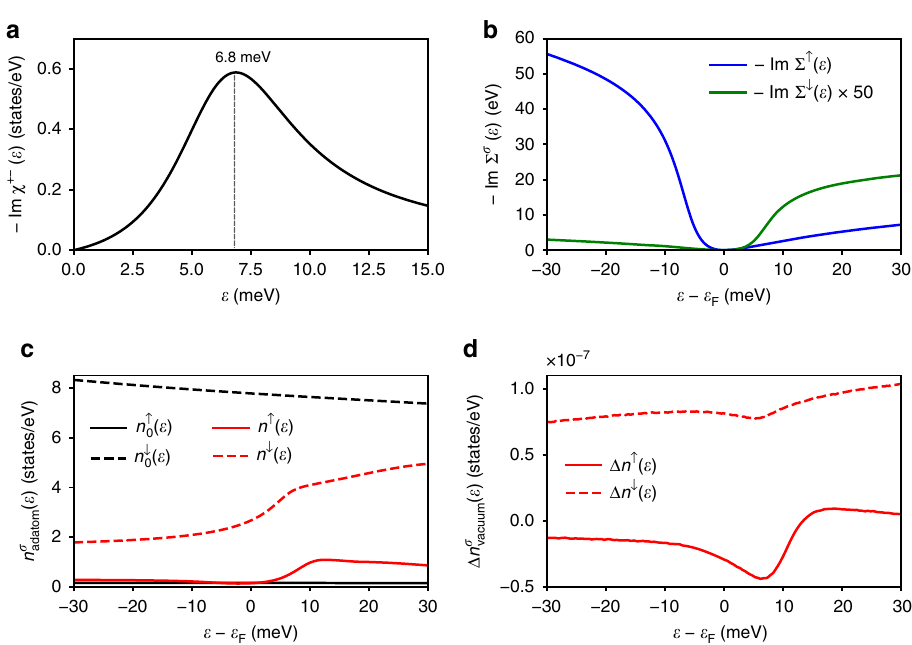
Fig. 2 Spin-excitations, self-energies and local density of states for Co adatom/Au(111). a Density of spin-excitations showing a broad resonance located at 6.8 meV, due to the adatom ’ s magnetic anisotropy energy. The lifetime of the spin-excitation is 0.29 ps, which is mainly settled by electron- hole excitations. b Spin-resolved electronic self-energy Σ after taking the trace over angular momentum indices, which inherits the information on the presence of the spin-excitation by hosting asymmetric steps above and below the Fermi energy. ↑ ( ↓ ) stands for majority-spin (minority-spin) . c LDOS at the adatom site before ( n 0 ) and after ( n ) accounting for the interaction between electrons and the spin-excitation. d Spin-resolved change in the LDOS ( Δ n ) calculated in the vacuum above the adatom. The minority-spin channel shows a low-intensity feature above the Fermi energy as expected from the corresponding self-energy. The large feature present in the majority-spin channel is composed of two steps, one originating from the intrinsic spin-excitation while the other is the spinaron, arising from the interaction of electrons and